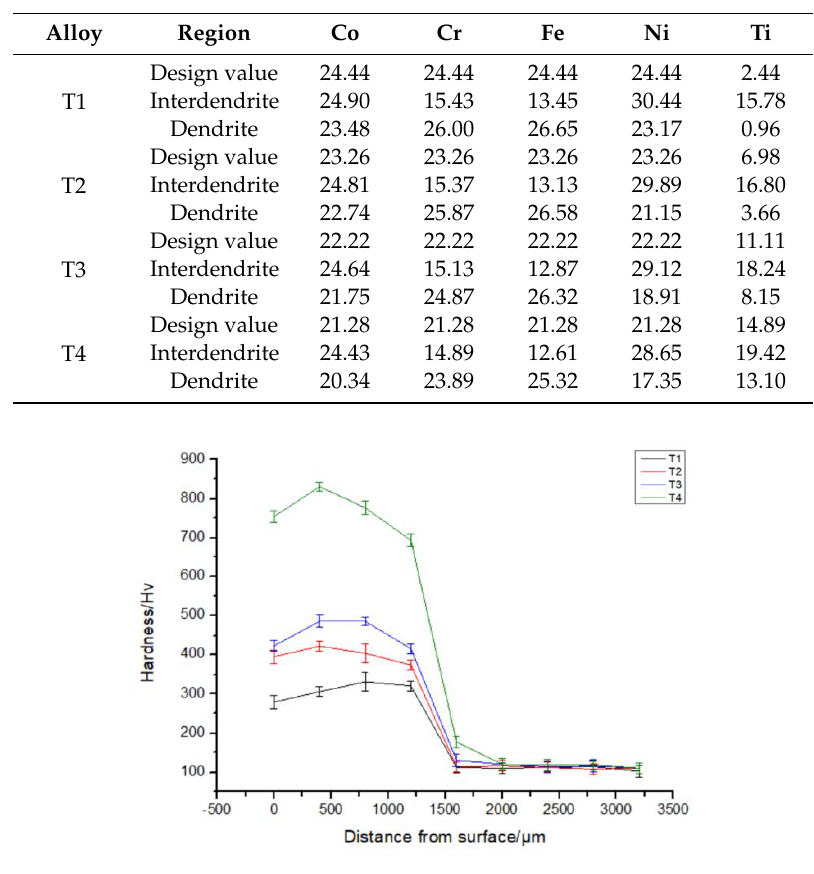
Figure 6. Cross-sectional hardness of CoCrFeNiTi x HEA coatings, where x = 0.1, 0.3, 0.5, or 0.7, and are abbreviated as T1, T2, T3, or T4, respectively.